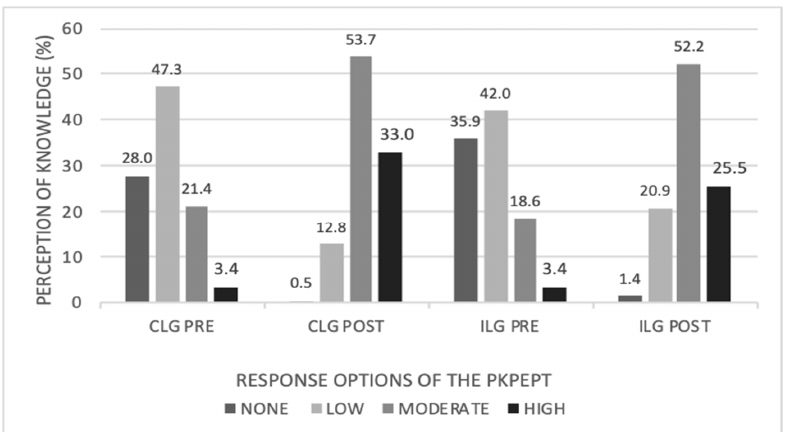
Figure 2. Number of participants that answered each score of the PKPEPT questionnaire, by group, before and after the innovative training methodologies. PKPEPT: Perception of Knowledge; CLG: cooperative learning group; ILG: individual learning group.